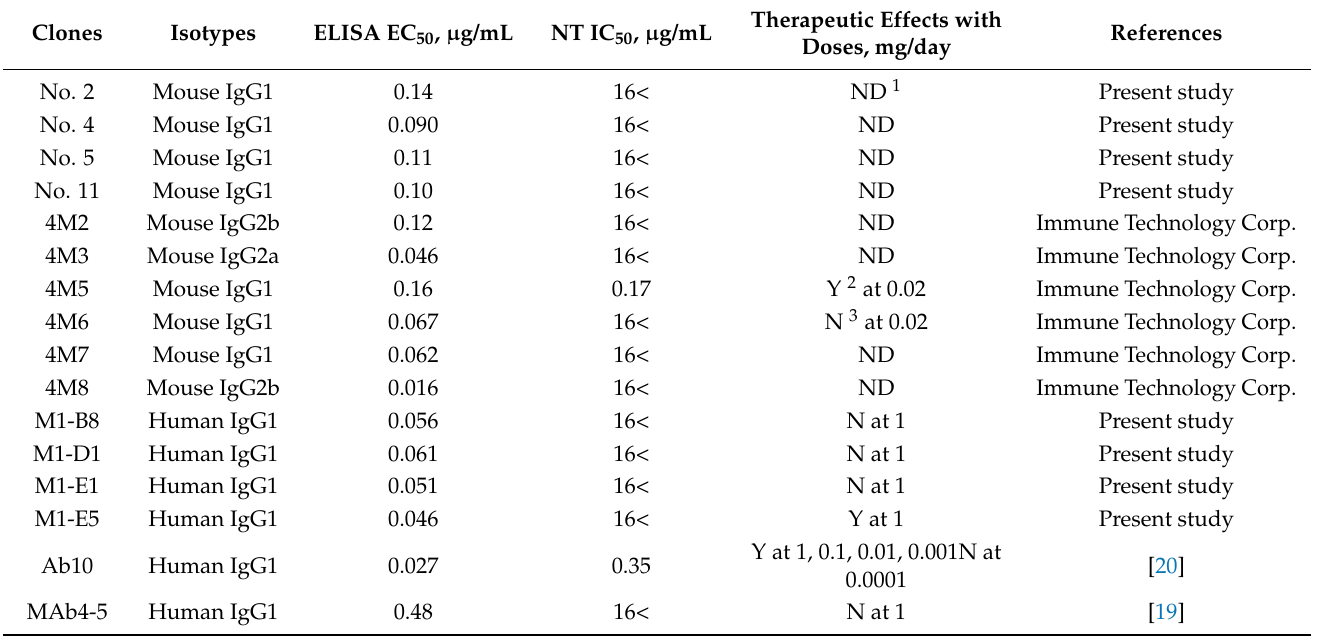
Table 1. mAbs specific to SFTS virus Gn protein.